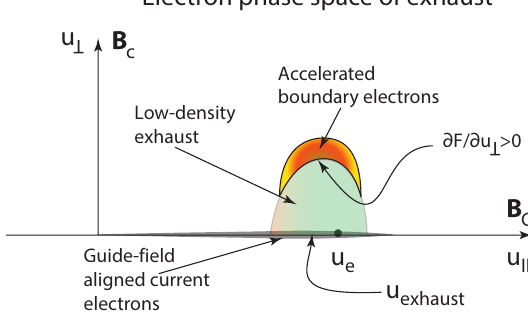
Figure 6. Mass-normalized momentum phase space of electrons in strong guide field exhaust with u = p /m . The guide-field-aligned current electrons have a broad electron distribution (similar to those observed in the AKR downward current region) shown here along the u (cid:107) axis which is also the direction of the guide field B g . The greenish region is the highly electron-diluted phase space domain of exhaust electrons. This region is filled with perpendicular drifting dilute electrons which move across the hole and magnetic fields by E × B g drift to the boundaries. The banana-shaped coloured region is filled with the exhaust electric field boundary electrons which form non-symmetric beams at the boundary of the exhaust which are directed parallel/antiparallel (depending on the part above or below the exhaust X point) to the reconnected field-aligned current magnetic field B 0 . It gives rise to a perpendicular phase space dis- tribution gradient ∂F( u )/∂u ⊥ > 0 which is capable of exciting the